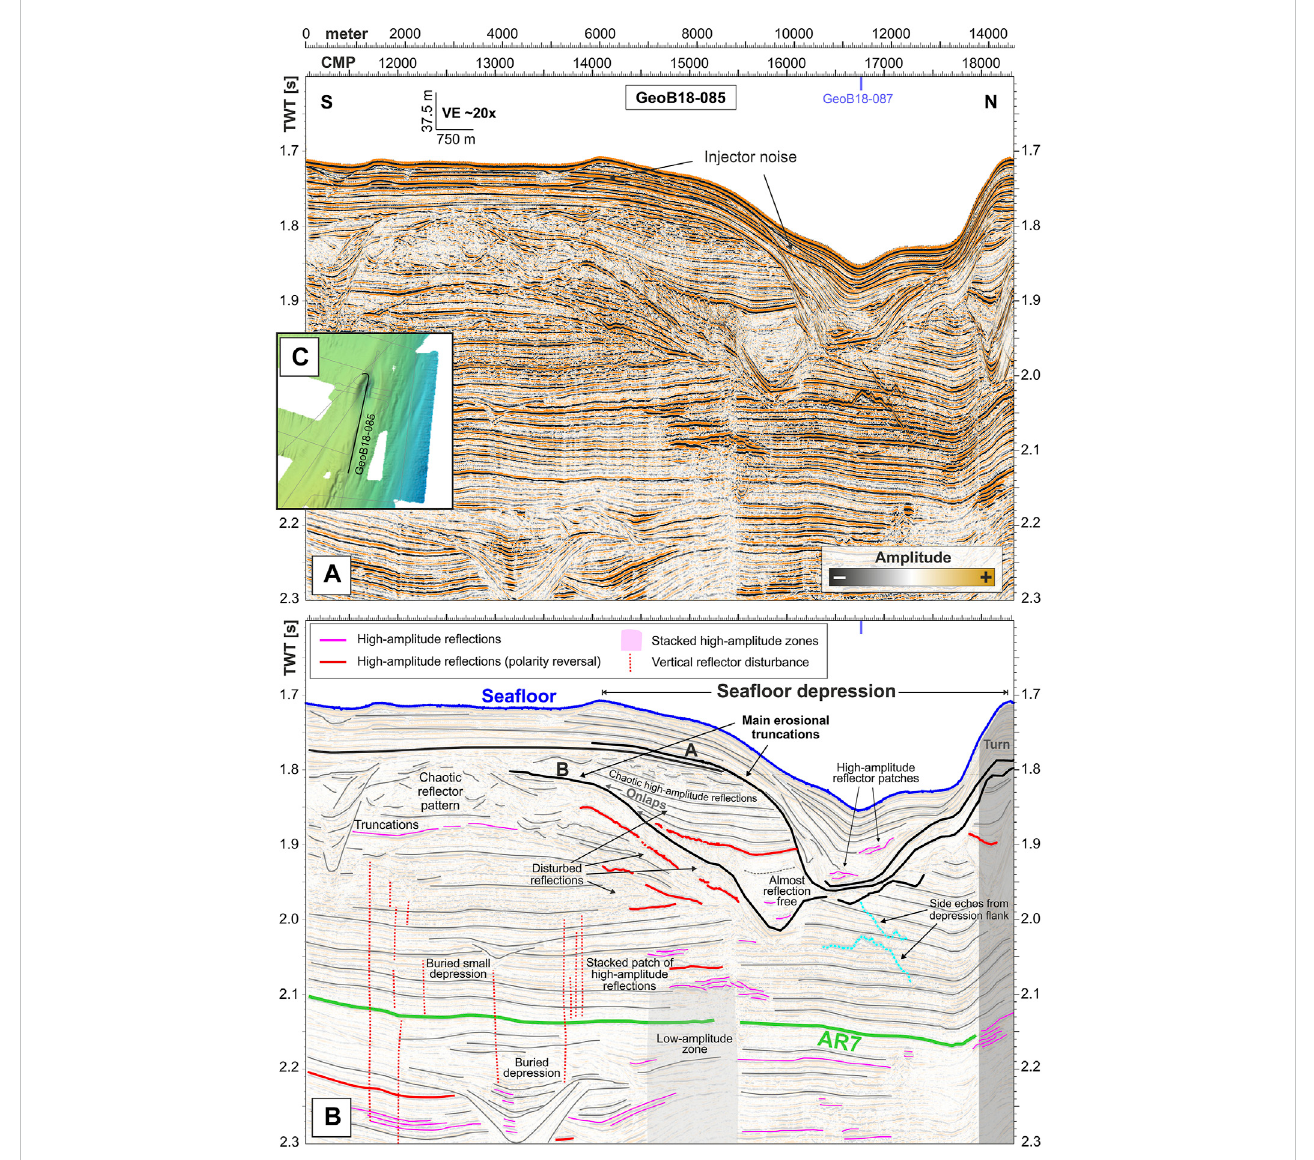
(cf. Section 2.3). Different amplitude anomalies like high amplitude patterns or re fl ections with reversed sea fl oor polarity might indicate the presence of gas and potential fl uid migration. (C) Bathymetry map showing pro fi le